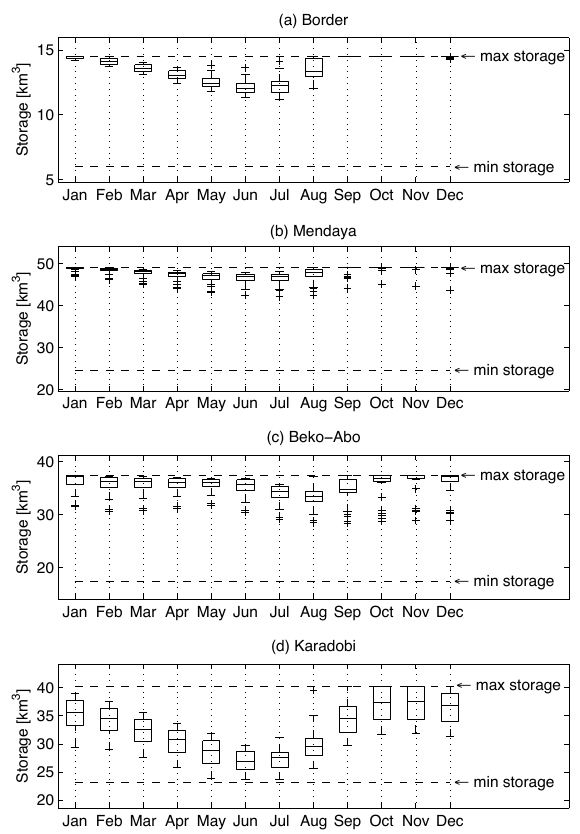
Fig. 3. Boxplots of the drawdown-refill cycles of the four multipurpose reservoirs in Ethiopia (Blue Nile) – scenario 3 (S3).